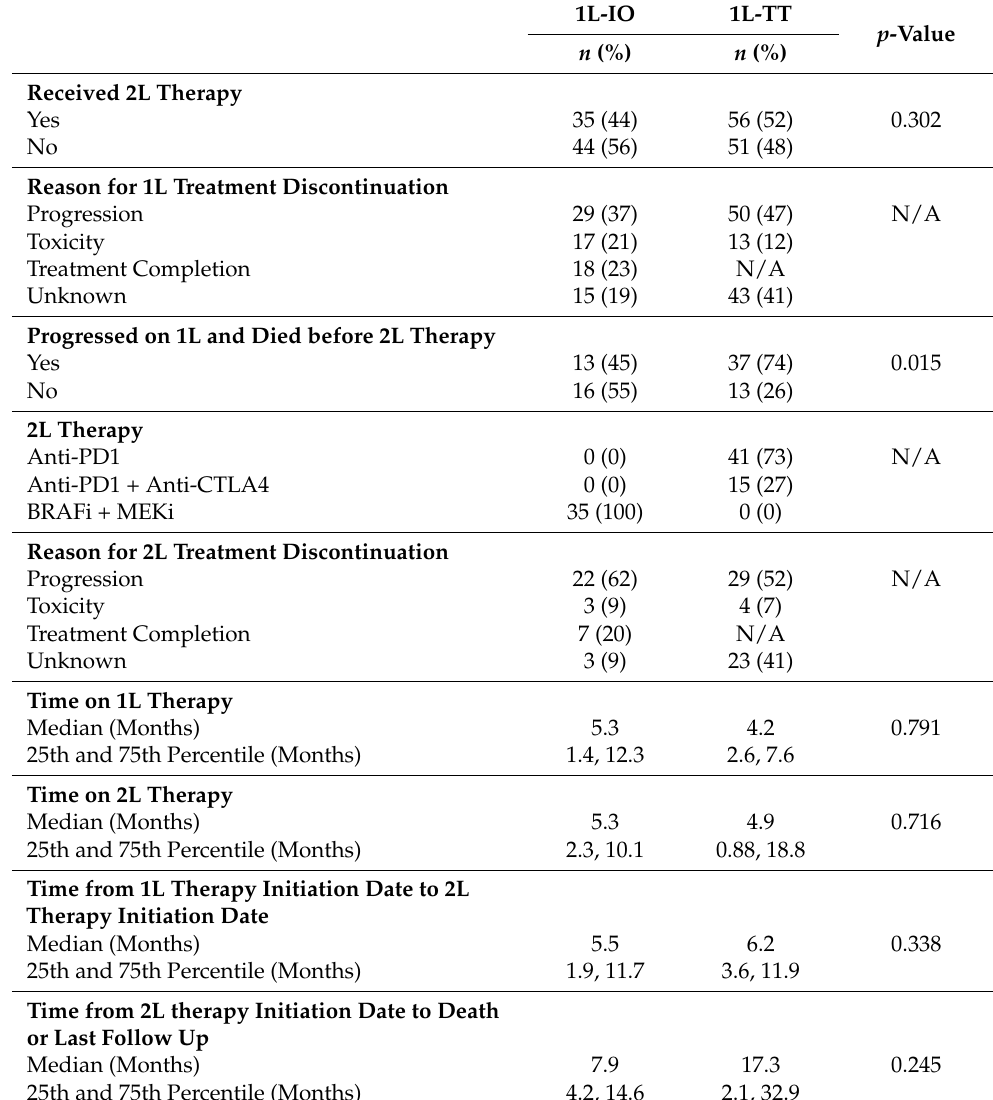
Table 2. Characteristics of 2L therapy and timing of sequencing patterns ( n =